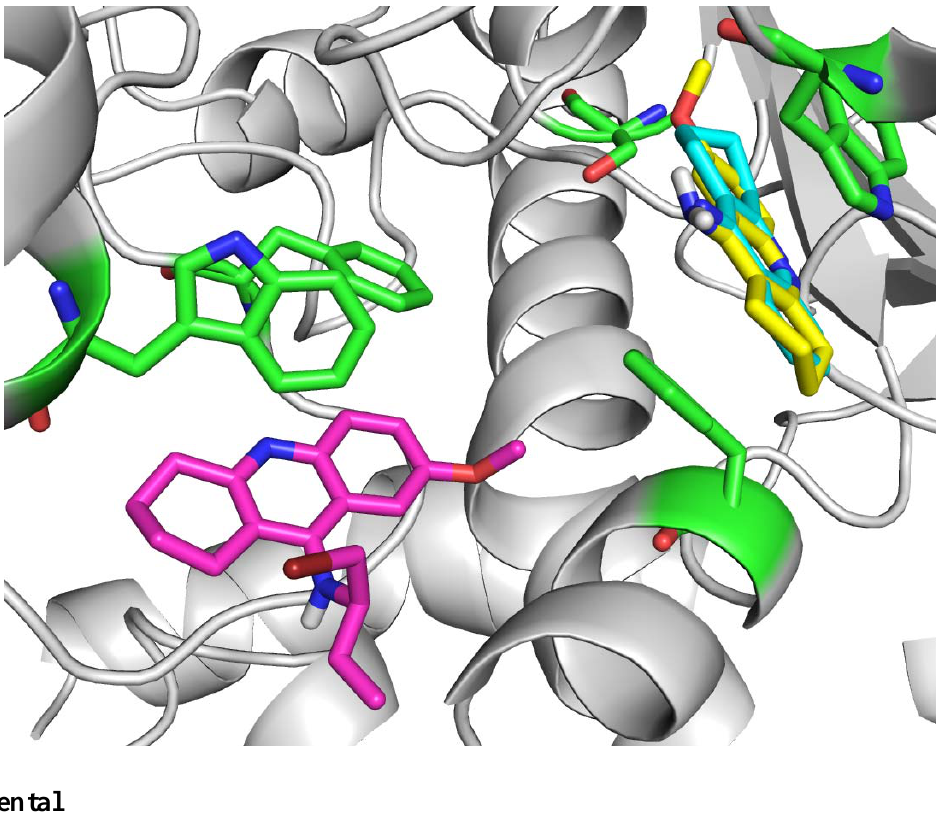
Figure 4. Molecular docking results for THA, 7-MEOTA and compound 1